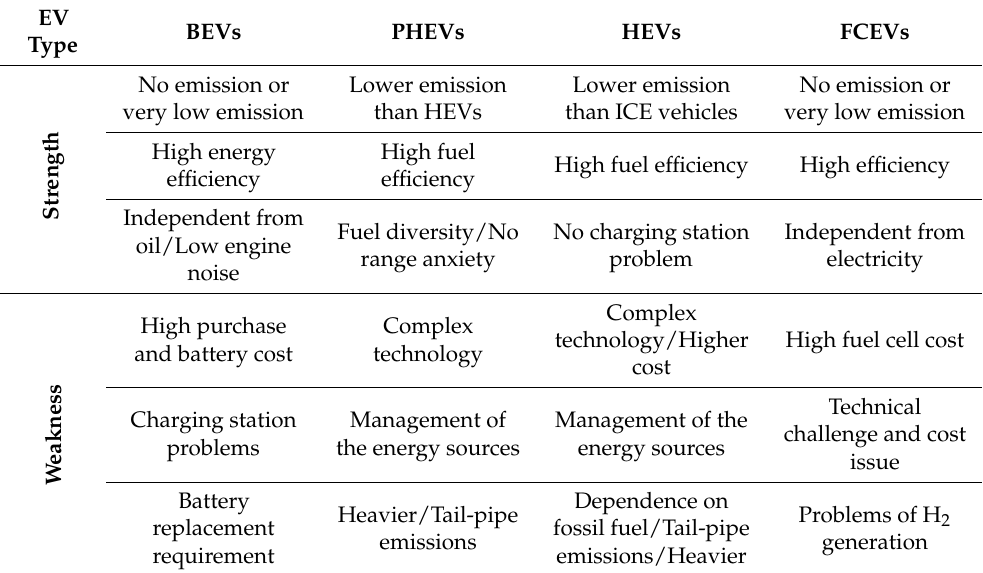
Table 1. Characteristics of different types of